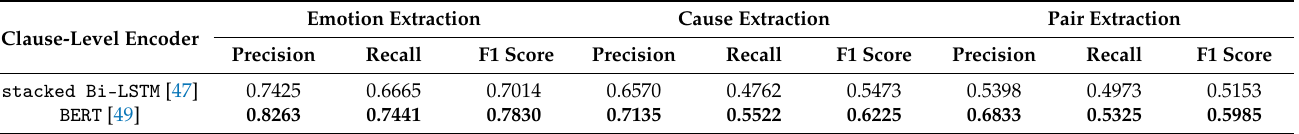
Table 4. Comparison of the model effects of Emiece composed of two different clause-level encoders. The results are under the same hyper-parameter